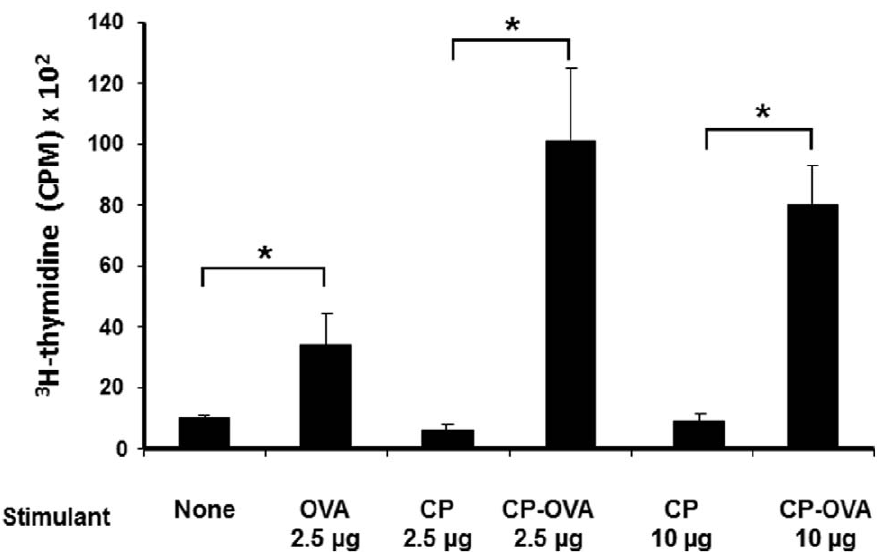
Figure 3. Vault nanocapsules induce CD4 T cell activation. T cells (2 6 10 5 cells/mL) were co-cultured with DC (2 6 10 4 cells/mL) in the presence of PBS, recombinant OVA protein (2.5 m g/mL), control CP-vaults and CP-OVA with the indicated concentrations. DC-induced T cell proliferation was assessed by incorporation of [ 3 H] thymidine. The graphs show mean (SEM) values from a representative experiment (n=6 replicates) of three independent experiments. Student’s t test was used to determine the p value by comparing appropriate control. *p ,